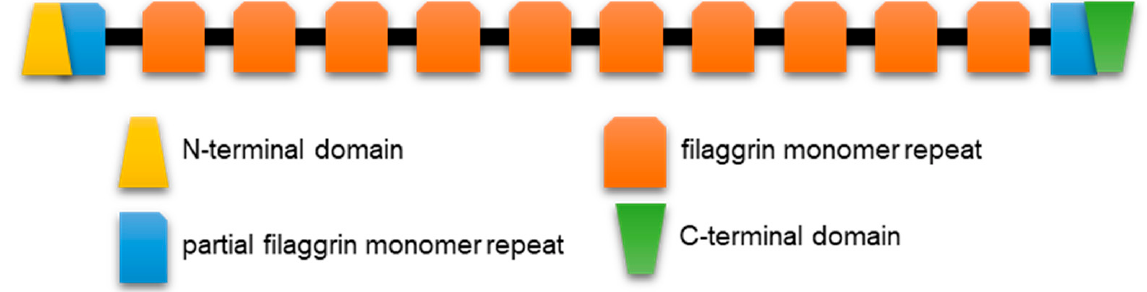
Figure 4. Protein schematic starting at the N-terminal domain (~290 amino acids) which includes sequence similarity to calcium-binding EF hands of the S100 protein family. Human profilaggrin has 10–12 complete repeats (~320 amino acids each) with linker regions of 19 amino acids. Mouse profilaggrin may have up to 16 repeats. C-terminal domain (~160 amino acids) sequences are required for proteolytic processing for monomer release.